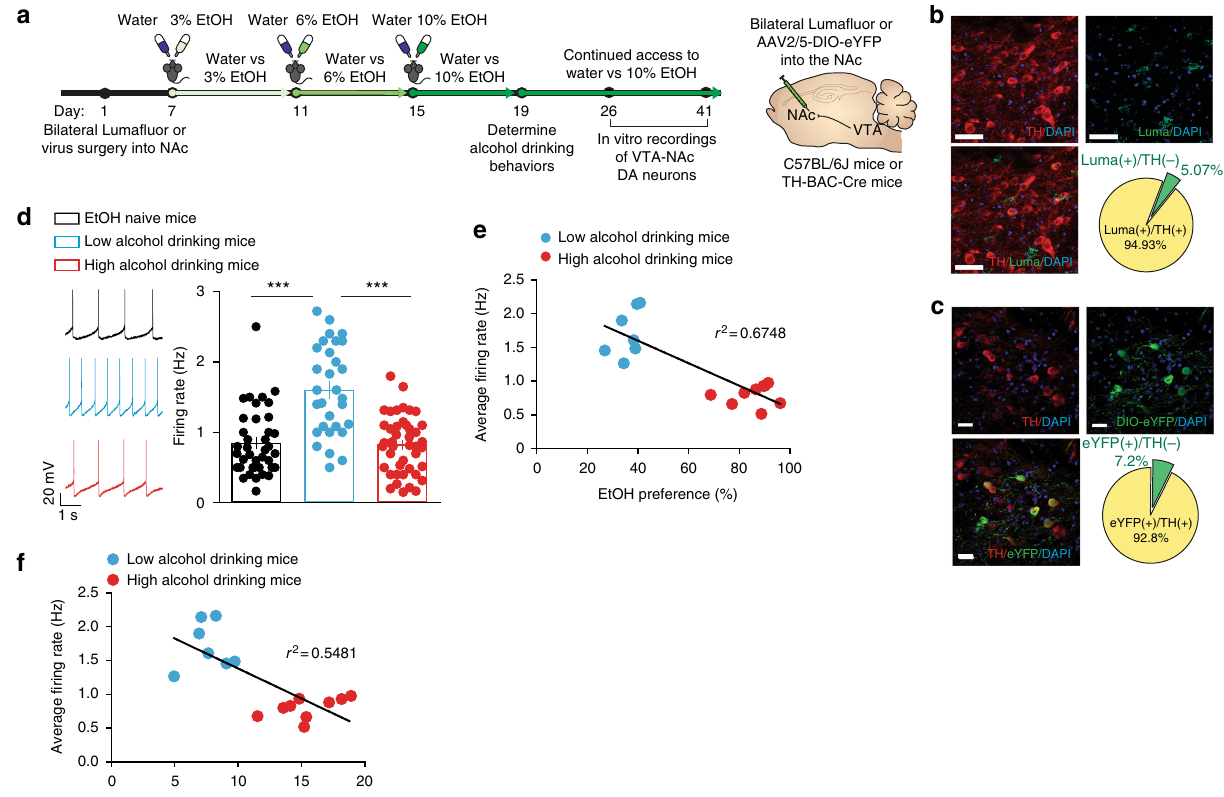
Fig. 4 Alcohol drinking mice display different fi ring properties in the VTA-NAc pathway. a Timeline of circuit dissecting electrophysiological experiments. b Colocalization of retrograded microbeads (Luma fl uor/Luma) from NAc in TH + neurons of the VTA ( n = 138 cells from 4 mice, scale bar = 50 μ m). c Colocalization of retrograded AAV5-DIO-eYFP from NAc in TH + (dopamine, DA) neurons of the VTA ( n = 153 cells from 5 mice, scale bar = 25 μ m). d Representative spontaneous fi ring rate traces (left) and grouped average fi ring rate (right) of VTA-NAc dopamine neurons in EtOH naive, low alcohol drinking, and high alcohol drinking mice (one-way ANOVA: F (2, 12.87) = 25.74, P < 0.0001; post hoc Bonferroni-multiple comparison test, *** P < 0.001. n = 39 cells from 7 mice; n = 30 cells from 7 mice; n = 43 cells from 9 mice). e Correlation of average VTA-NAc neuron fi ring rate and EtOH preference from alcohol drinking mice ( r 2 = 0.6748, P < 0.0001. n = 16 mice). f Correlation between average VTA-NAc neuron fi ring rate and EtOH intake across 24 h from alcohol drinking mice ( r 2 = 0.5481, P < 0.001. n = 16 mice). Data represented as mean +